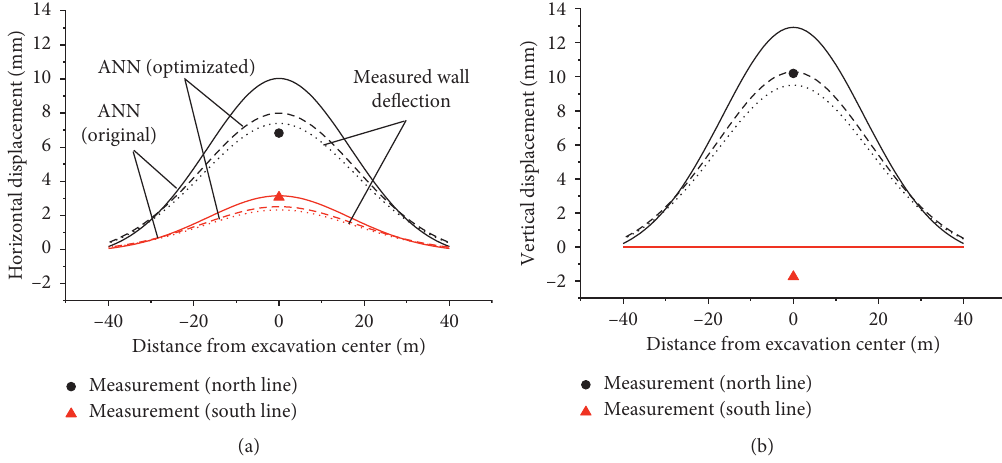
Figure 7: Comparison between measured and predicted tunnel displacements caused by adjacent excavation.